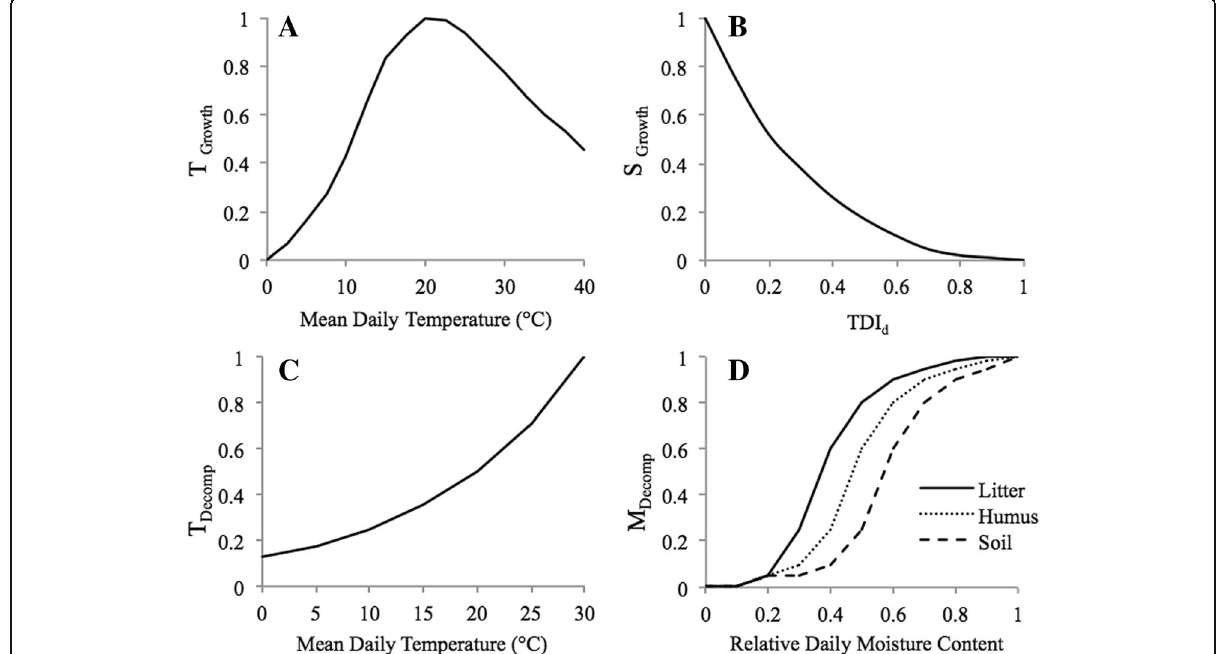
Fig. 2 Climate response functions used in FORECAST Climate related to Chinese fir. These functions illustrate the relationship between daily growth rate for Chinese fir and a mean daily temperature, b daily water stress; and the response of decomposition rates to c mean daily air temperature (based upon a Q 10 of 2), and d relative daily moisture content, for litter, humus and soil